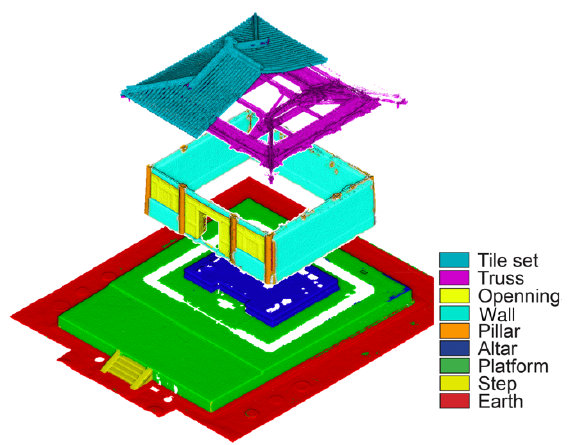
Figure 5. Classification result at level 2 in NCS.